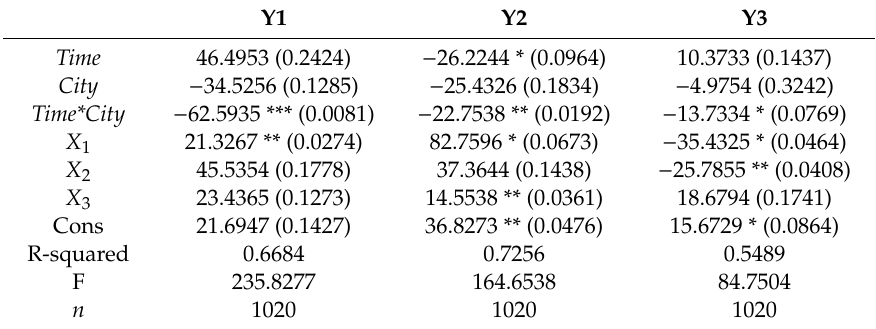
Table 6. Regression results of energy conservation and emission reduction related